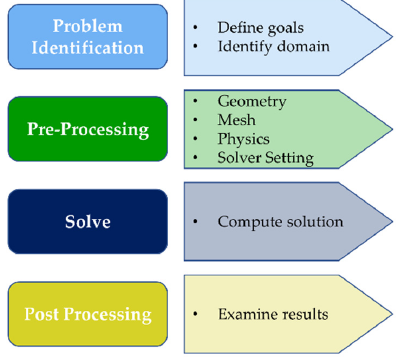
Figure 7. FEM simulation’s environment.